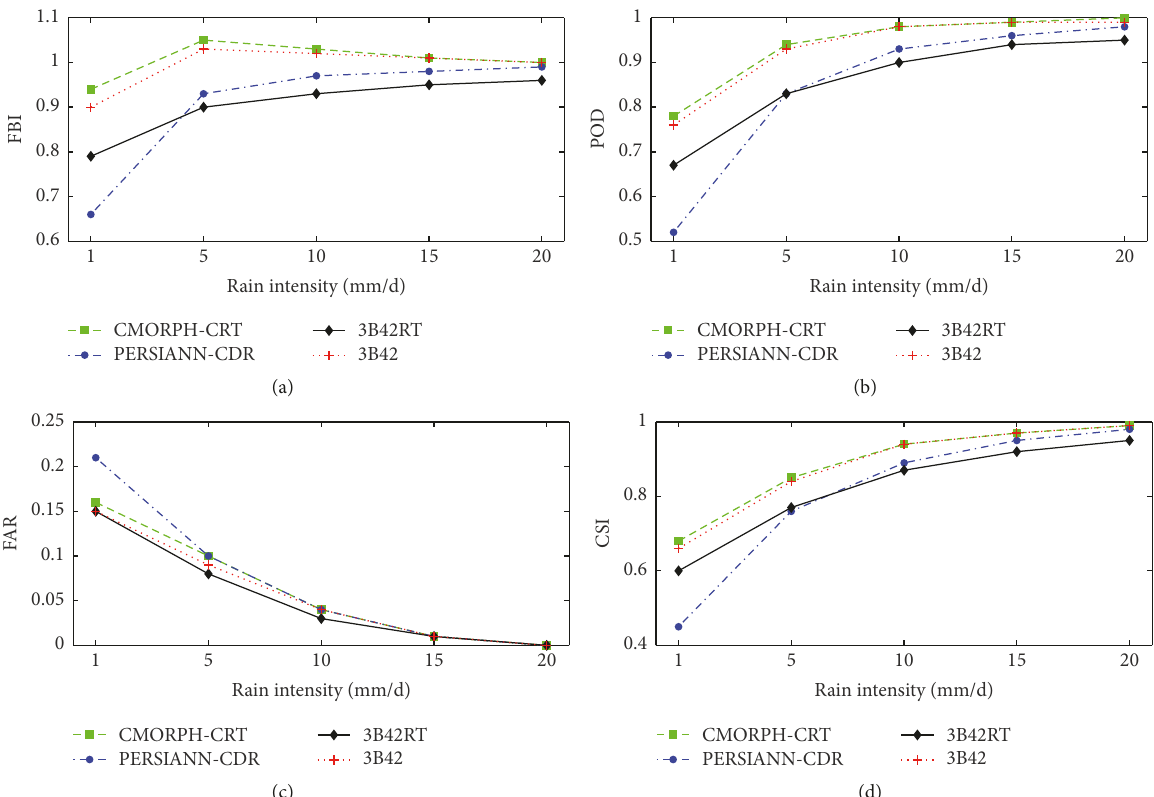
Figure 8: FBI (a), POD (b), FAR (c), and CSI (d) of daily average between the four satellite estimates and gauge observations over the GRB.